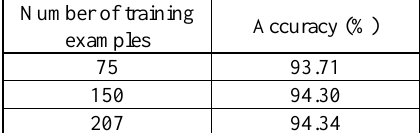
Table 2. Accuracy for STOP sign in conjunction with